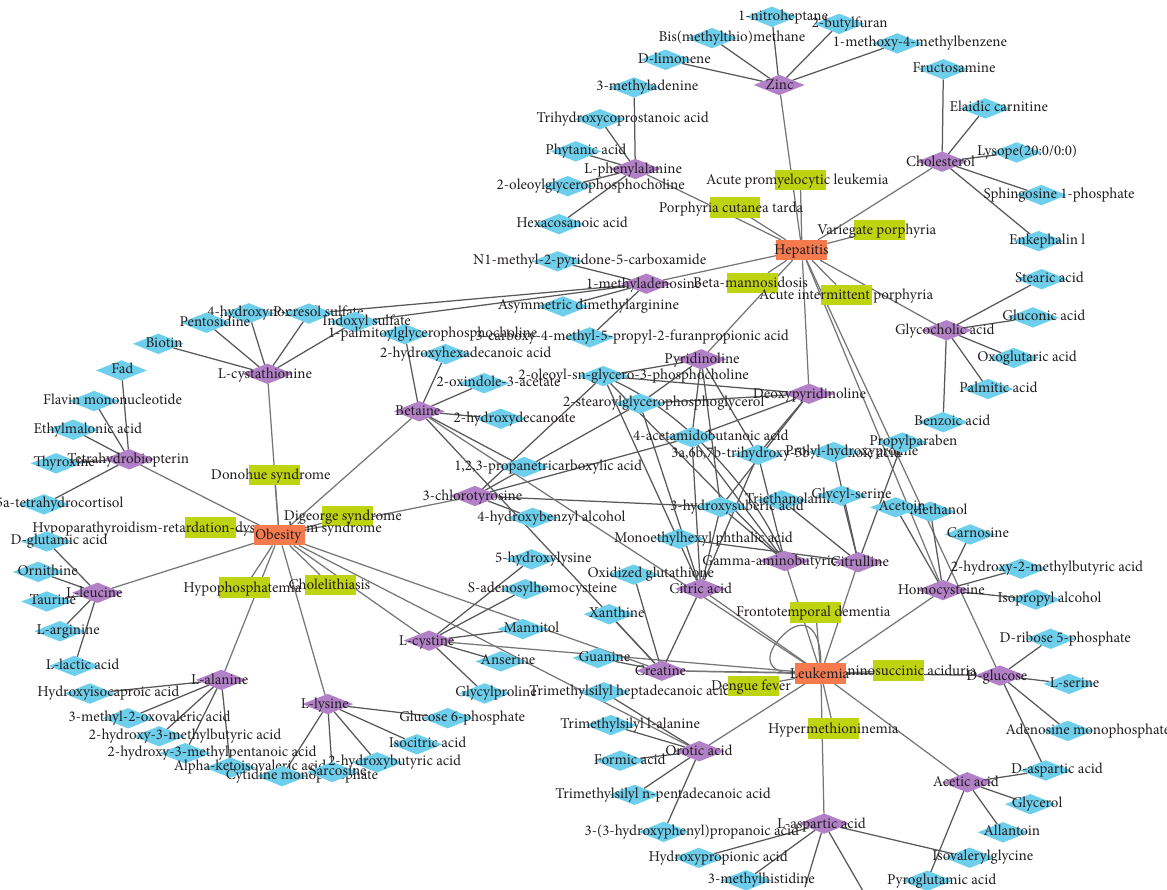
Figure 6: The predicting disease-metabolite association network. Three diseases and their relevant top 10 metabolites in cases studies are selected. Moreover, their top 5 relevant neighborhoods are shown. The rectangle represents diseases, and diamond represents metabolites. The orange represents target diseases, and the green represents their relevant neighborhoods. The purple represents the predicted me- tabolites, and the blue represents their relevant